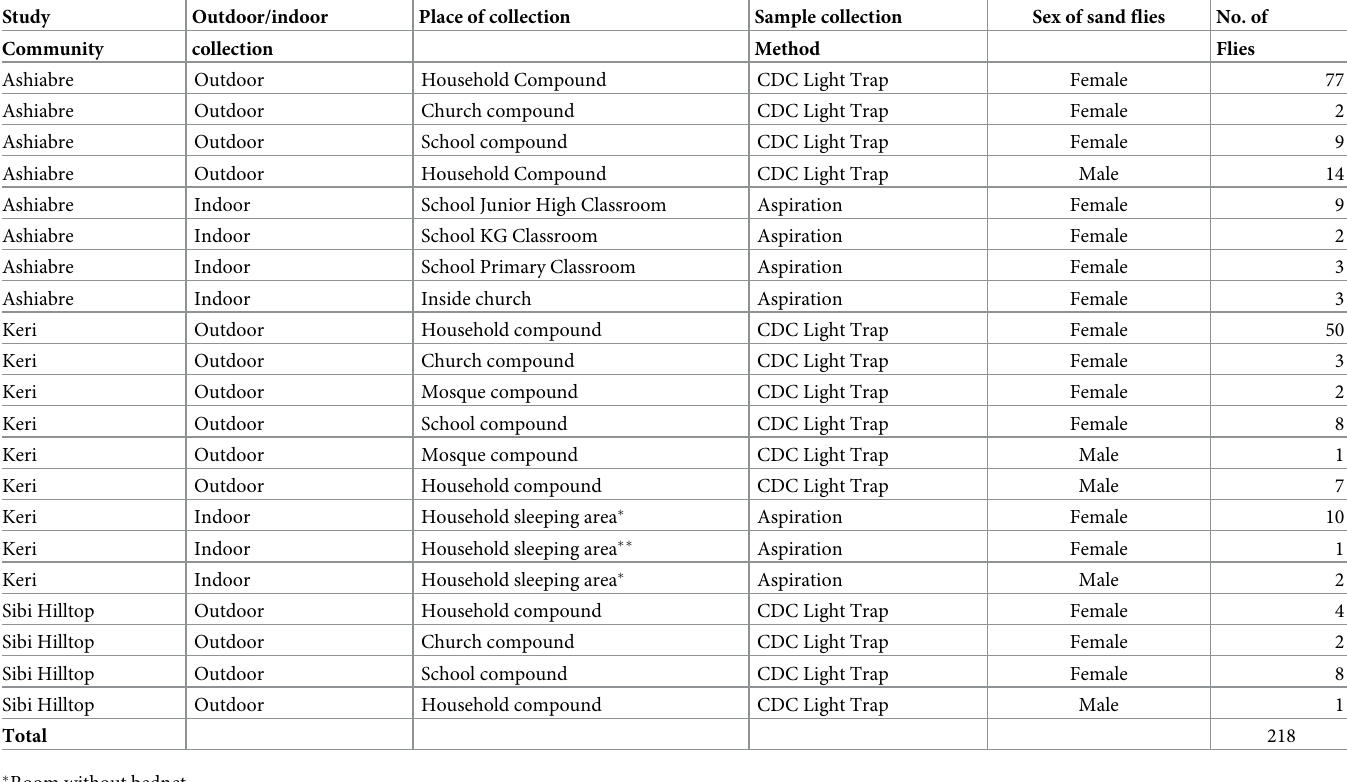
Table 12. Summary of sandflies caught in study communities by sex, place of collection, and collection